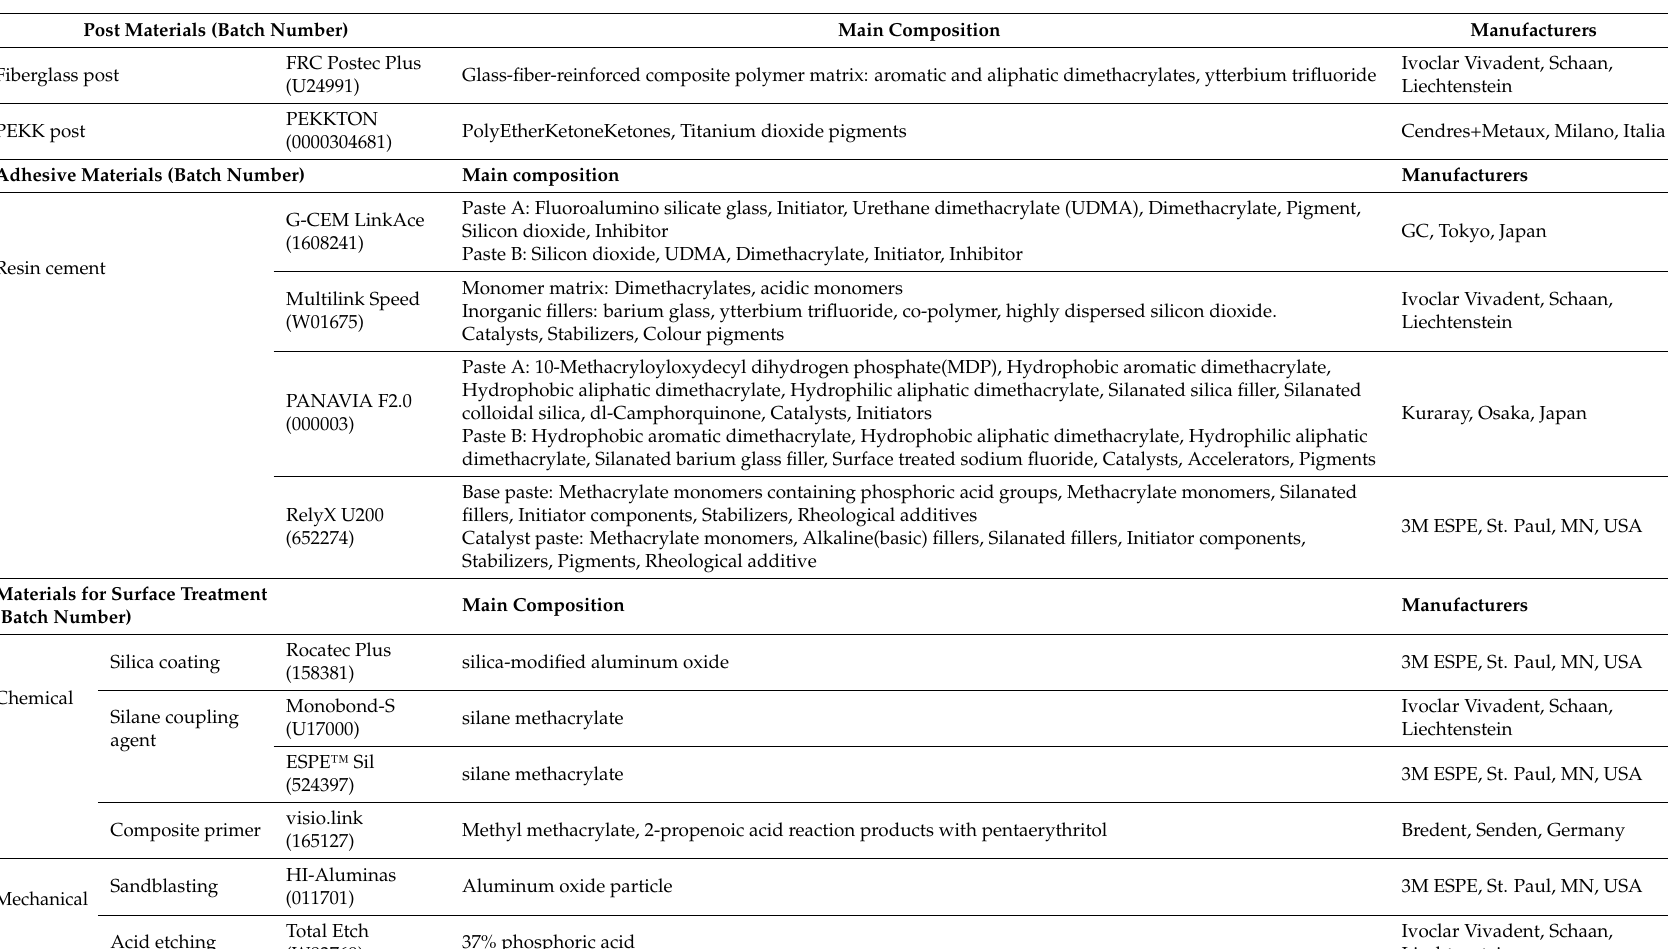
Table 1. The list of materials and their